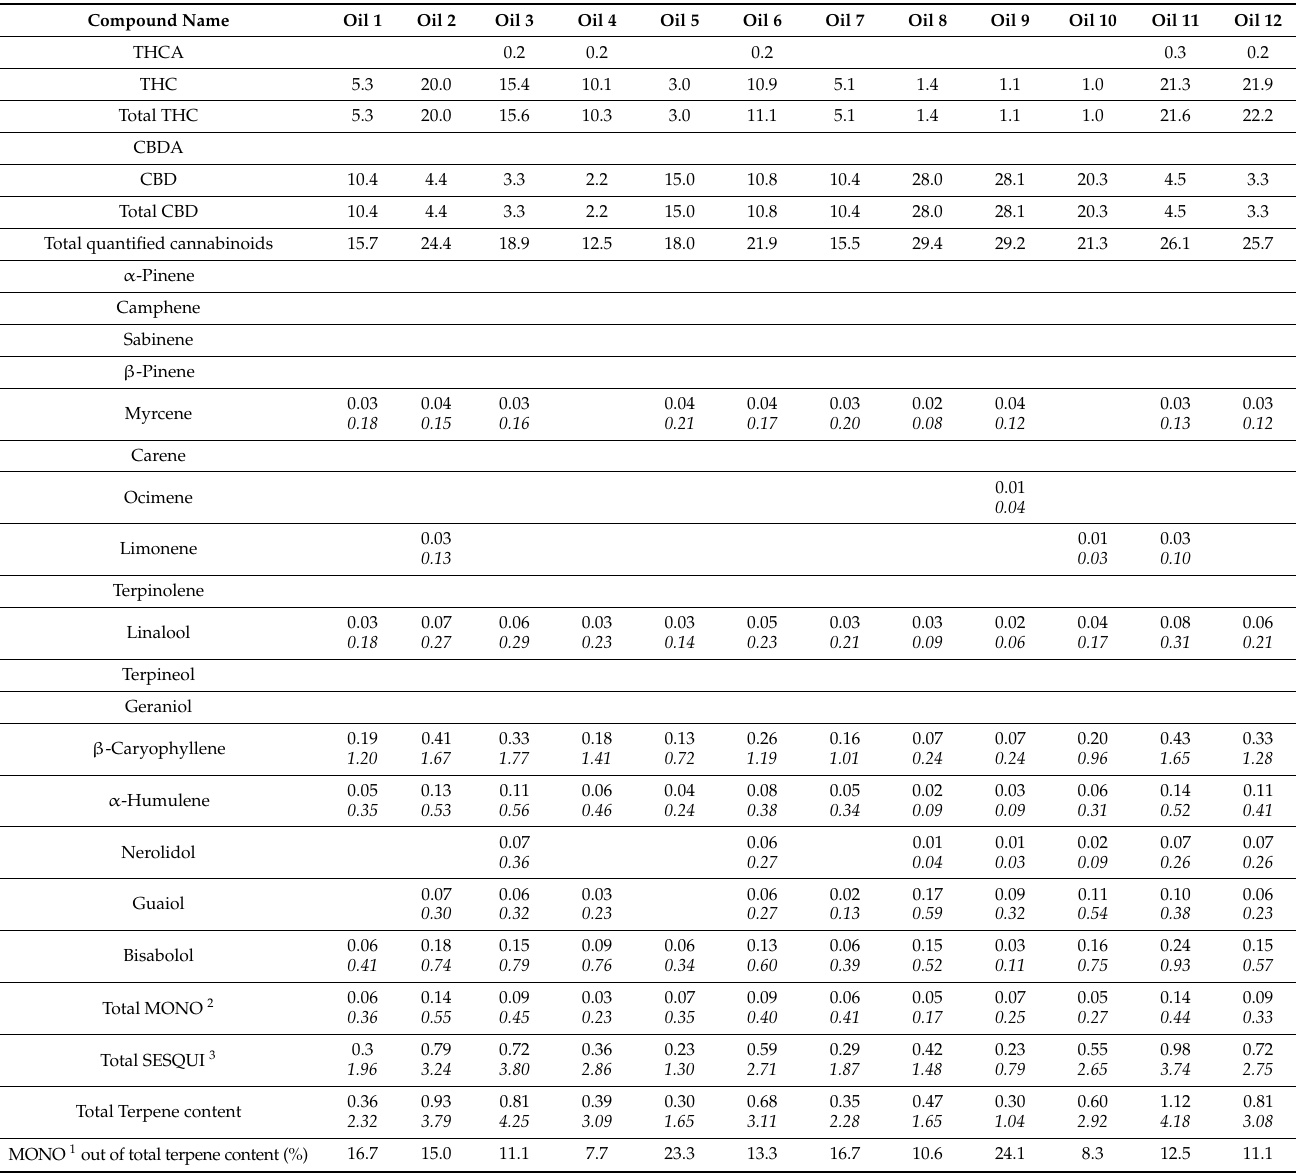
Table 3. Cannabinoid and terpene compositions in commercial cannabis oil products in Israel. Data is presented as absolute percentage 1 and in the form of milligrams of each terpene per 100 mg total cannabinoid content ( in italic